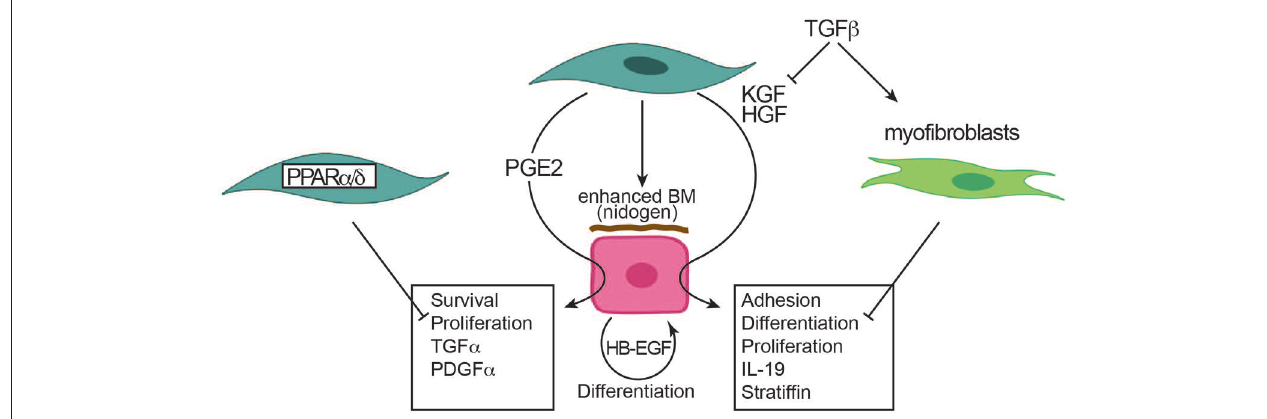
FIGURE 5 | Effects of fibroblasts on keratinocytes. Arrowheads indicate enhancement. Blunted heads indicate inhibition. BM, basal membrane; HB-EGF, heparin binding EGF like growth factor; HGF, hepatocyte growth factor; IL, interleukin; KGF, keratinocyte growth factor; PDGF, platelet derived growth factor; PGE2, prostaglandin E2; PPAR, peroxisome proliferator-activated receptor; TGF, transforming growth factor.